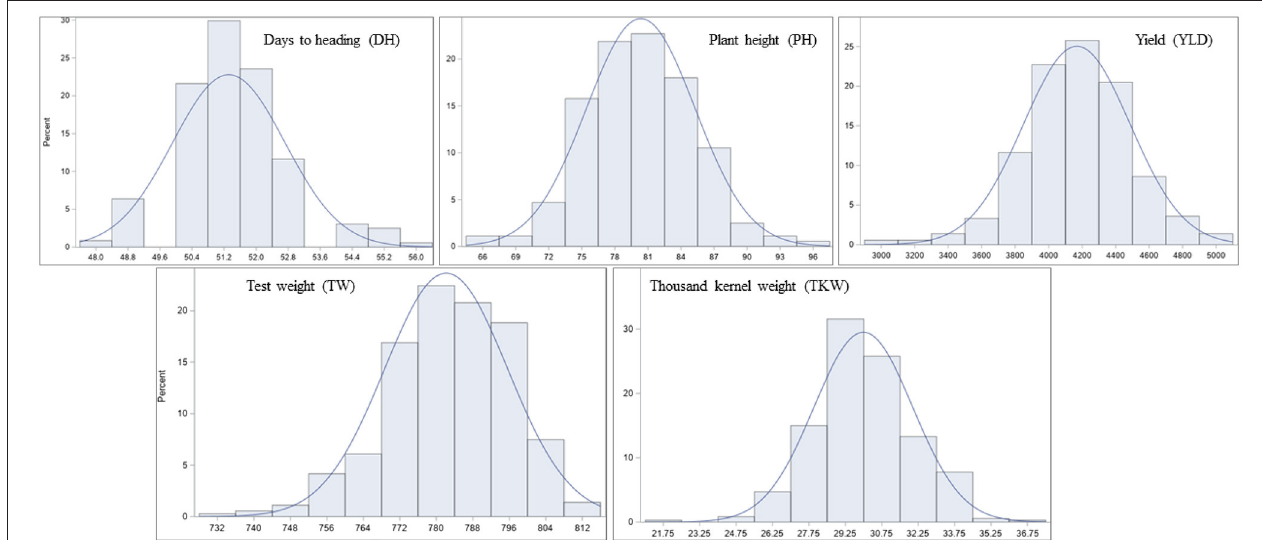
FIGURE 1 | Frequency distribution of least-square means (lsmeans) for the agronomic traits in the hard red spring wheat panel across environments. The panel was evaluated for days to heading (DH), plant height (PH), yield (YLD), test weight (TW), and thousand kernel weight (TKW) in nine different environments of North Dakota in 2012, 2013, and